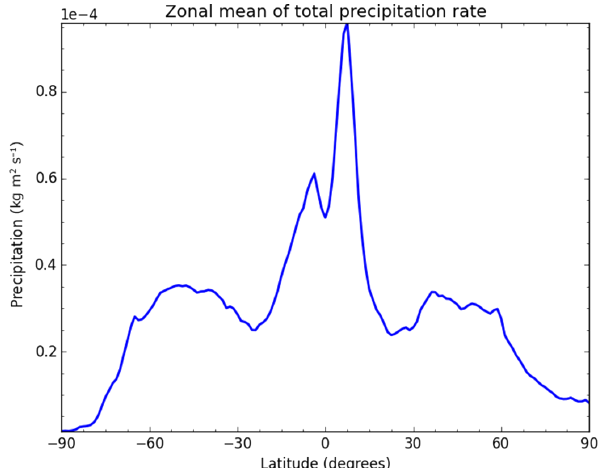
Figure 3. A plot of the zonal average of global rainfall, demonstrat- ing the simple aggregation of global model outputs using CIS. See the text for the exact command used to produce this